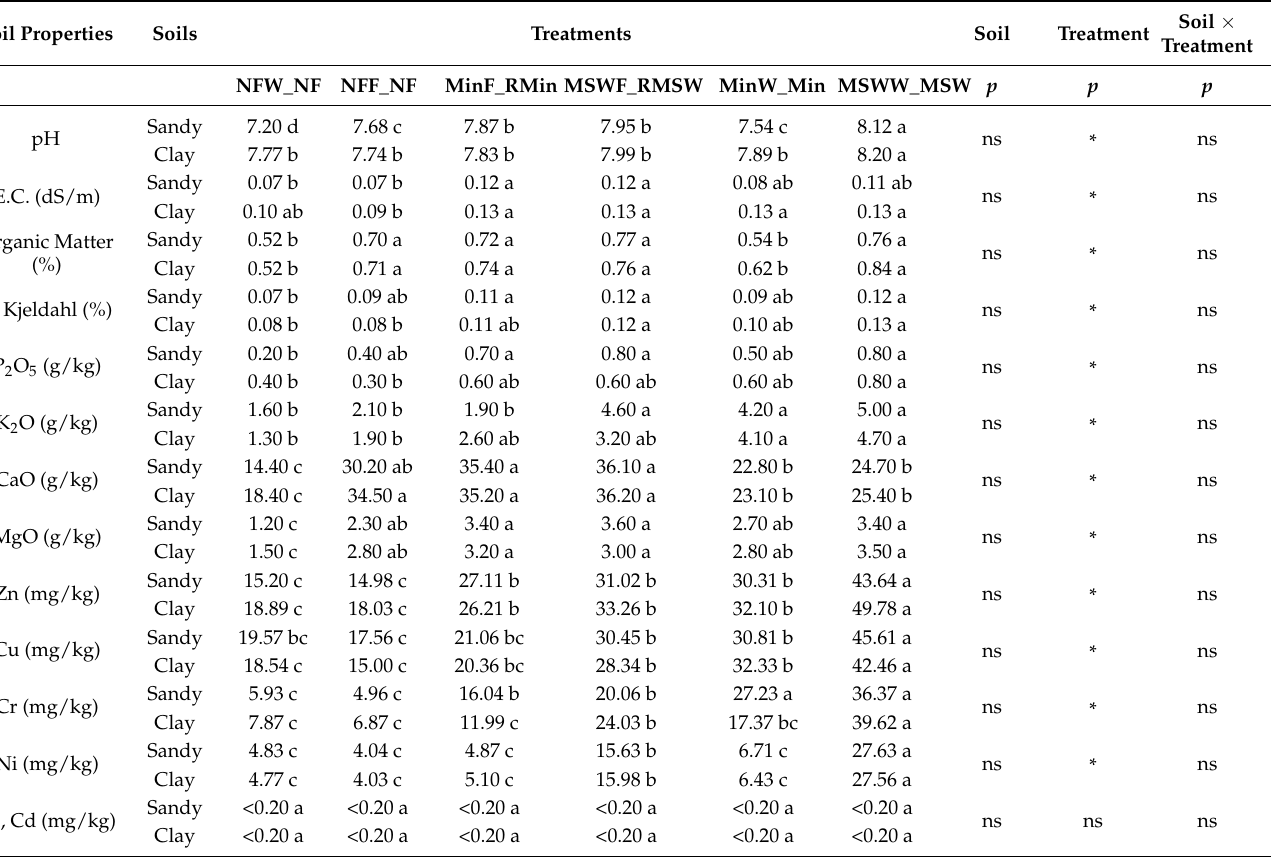
Table 4. Effect of organic fertilization with bio-stabilized MSW amendment and mineral fertilization on soil properties, soil nutrients, and heavy metals. Factors’ effects over the measured variables were assessed as not significant (ns) or statistically significant (*) for p < 0.05 (mean values with different letters in the same row vary